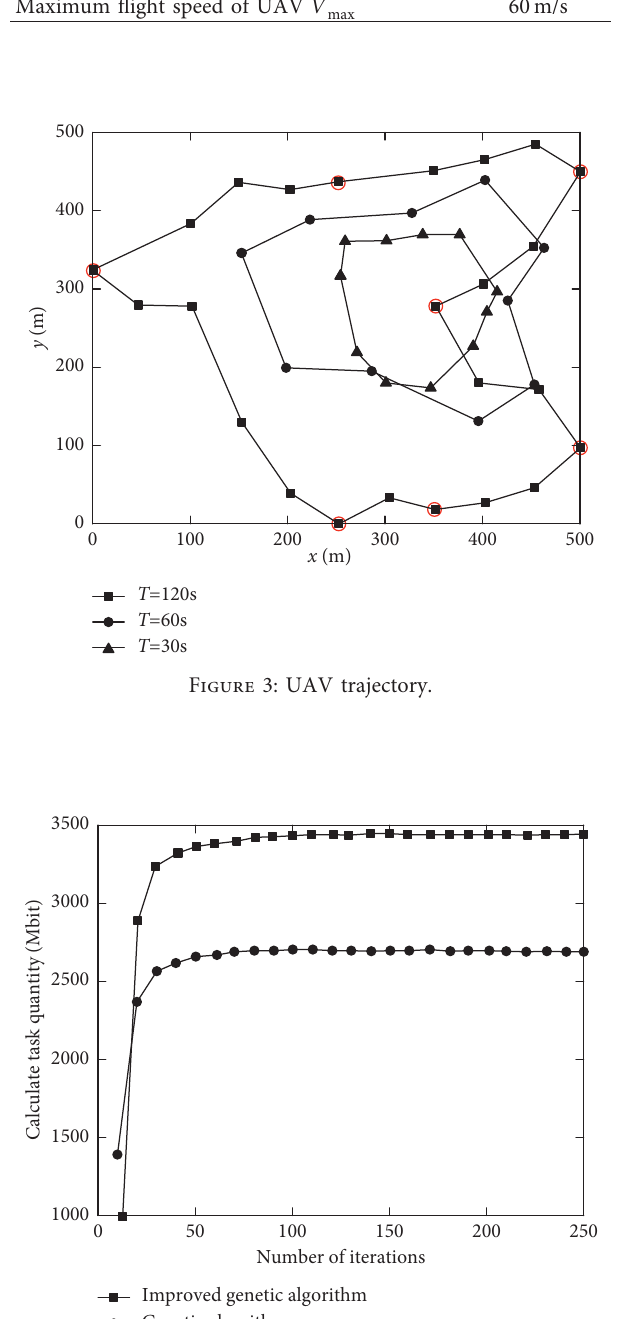
Figure 4: Convergence performance of genetic algorithms before and after improvement.